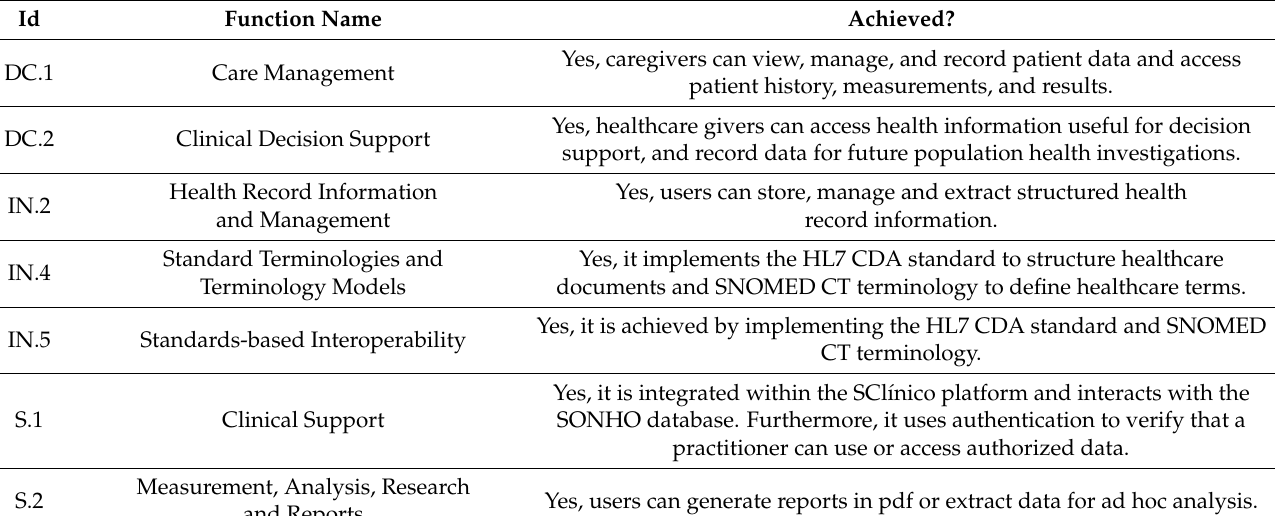
Table 2. The achieved functionalities [23,24].